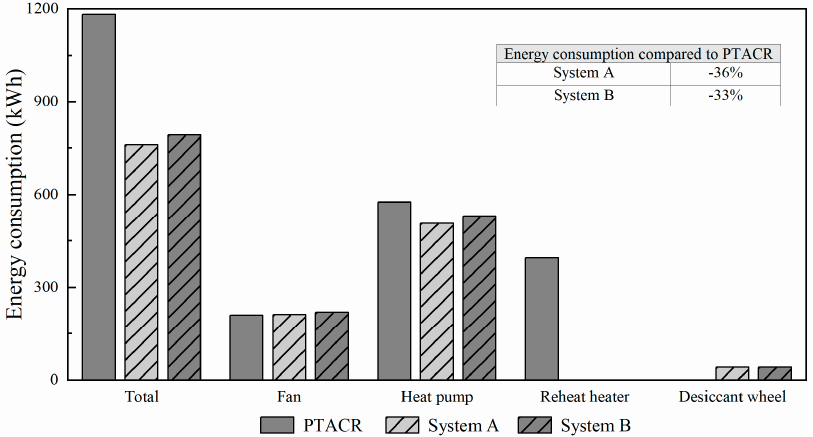
Figure 8. Energy consumption of the three studied systems.